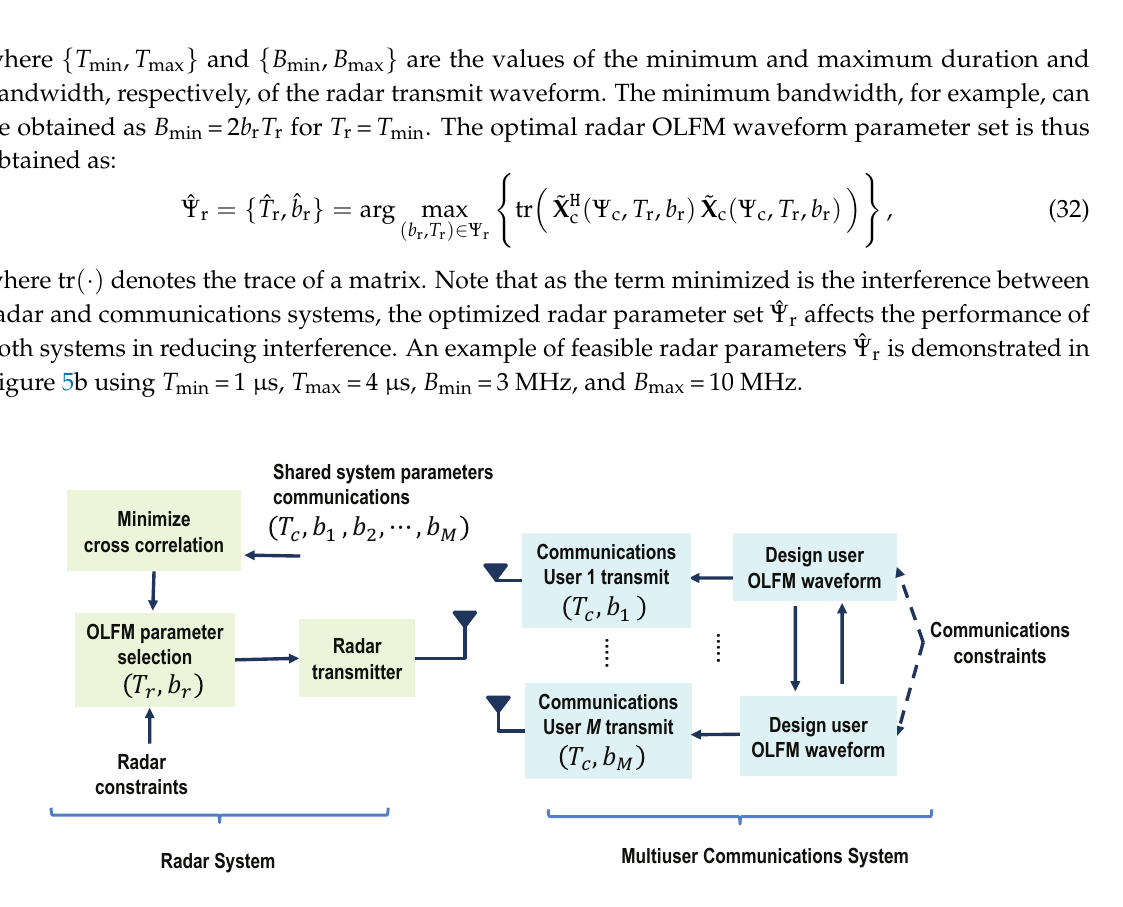
Figure 6. Block diagram overview of the coexistence waveform design Approach I-B: The radar receiver has knowledge of the OLFM waveform parameters, { T c , b 1 , . . . , b M } , used by the M communications